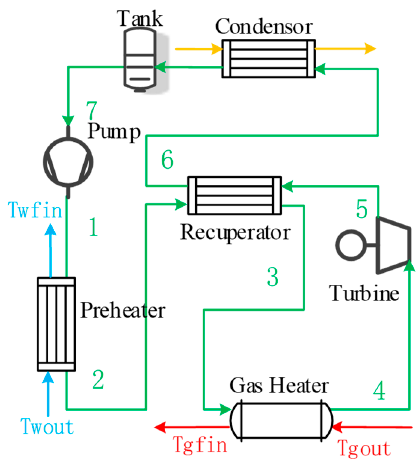
Figure 4. Schematic diagram of the waste heat recovery system.